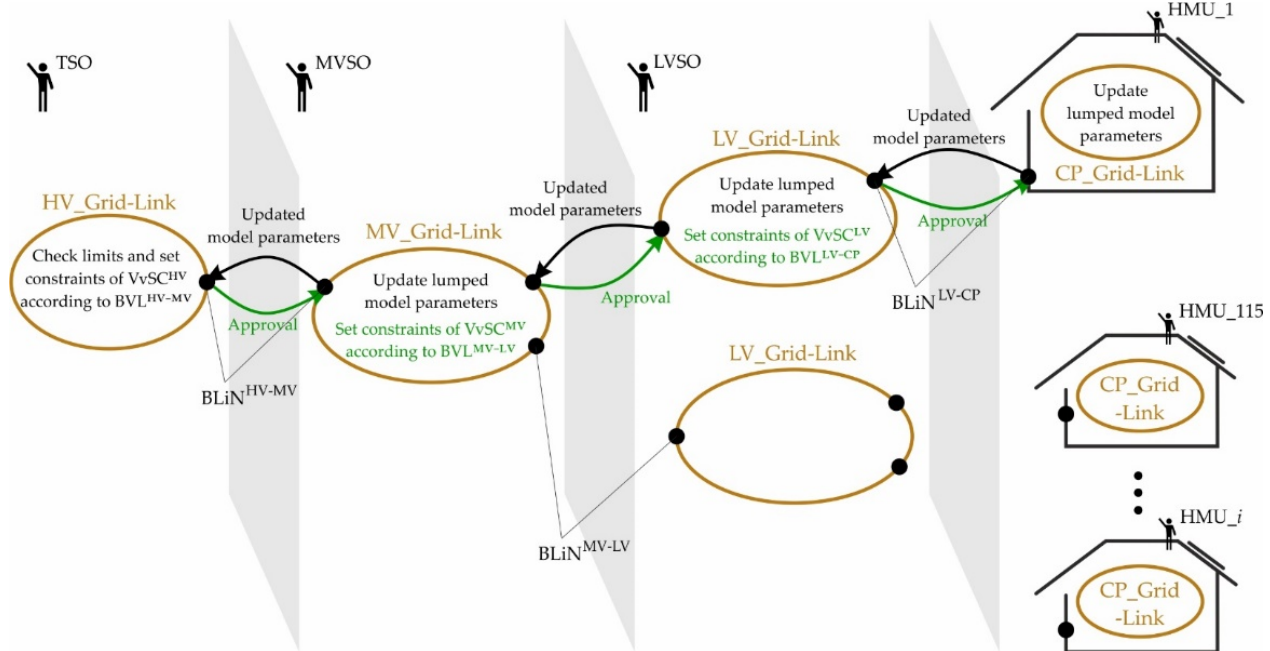
Figure 21. LINK -based s hort-term BVL adaptation chain.